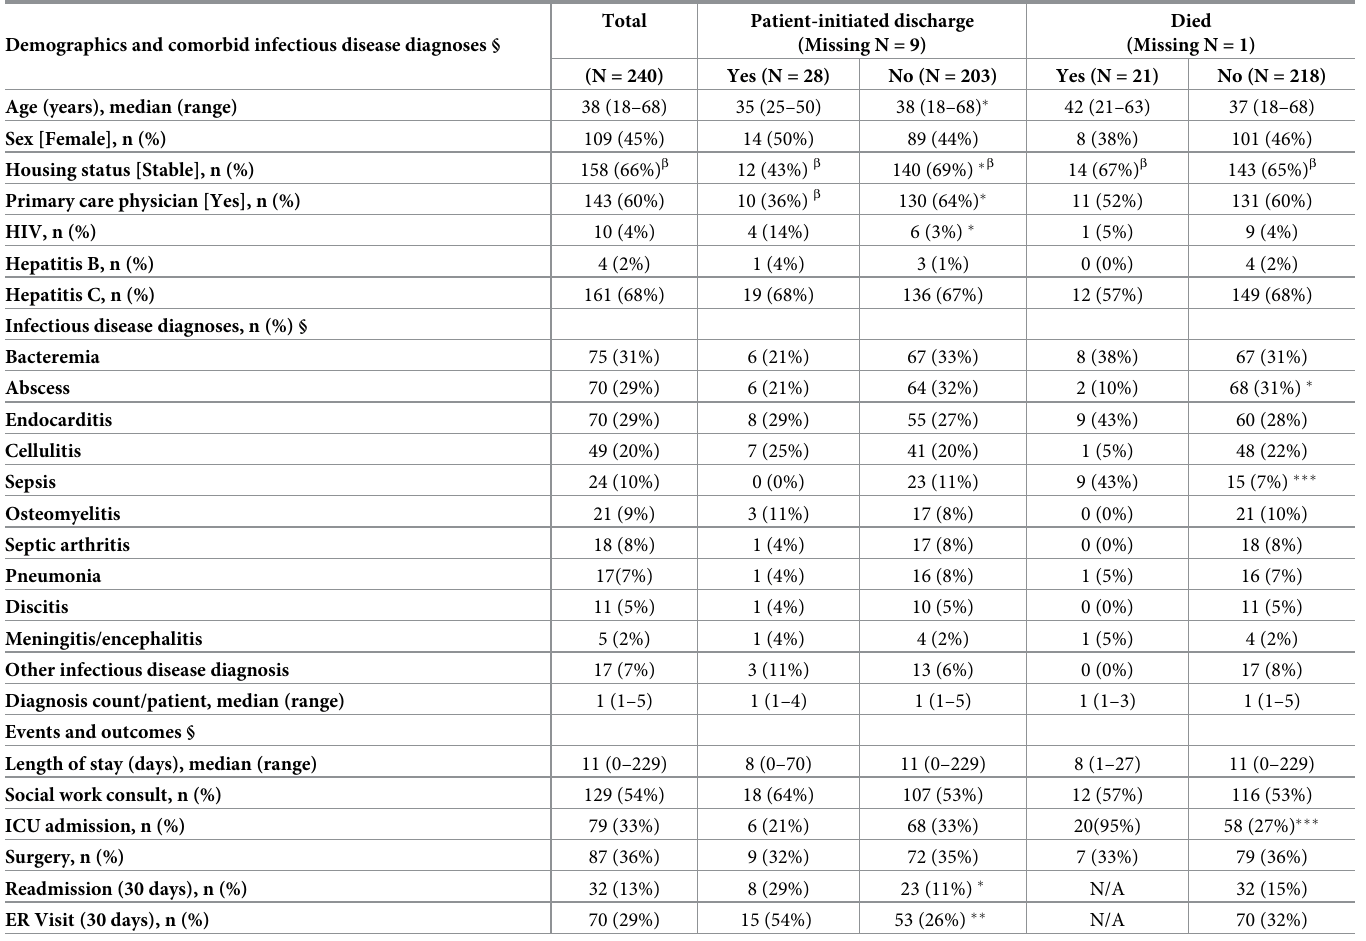
Table 1. Demographics, infectious disease diagnoses and outcomes. Demographics and comorbid infectious disease diagnoses